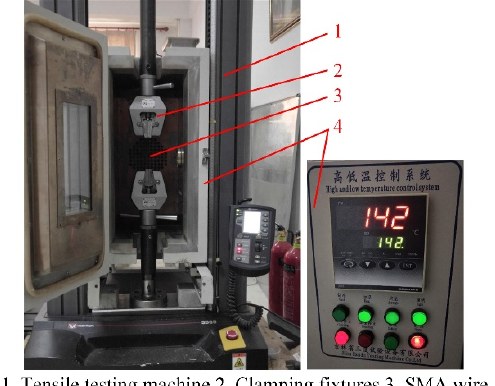
Figure 3. The loading experiments at 25 °C and 100 °C.